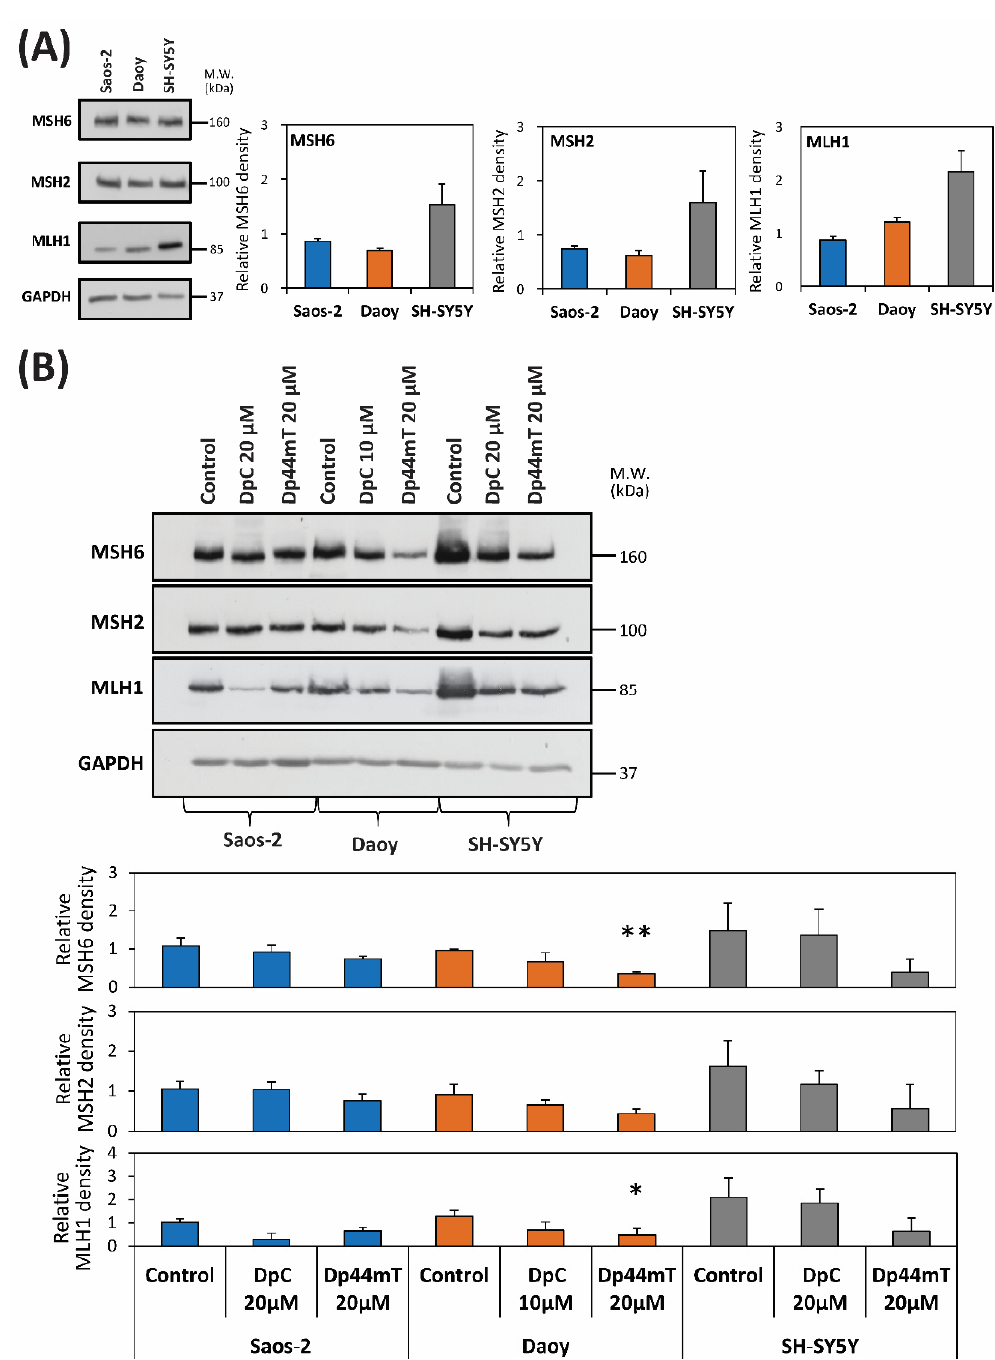
Figure 5. Changes in the expression of MMR proteins after incubation with either control medium, DpC (20 μ M; 10 μ M for Daoy), or Dp44mT (20 μ M) for 24 h/37 °C. ( A ) Western blot analysis of endogenous MSH6, MSH2 and MLH1 levels in untreated cells. ( B ) MSH6, MSH2 and MLH1 levels in Saos ‐ 2, Daoy and SH ‐ SY5Y cells after incubation with DpC or Dp44mT for 24 h. GAPDH served as a protein ‐ loading control. The western blots presented are from a typical experiment of three performed, while the quantitation of the blots is presented as mean ± SD (3 experiments). These data were analyzed using the unpaired Welch’s t ‐ test followed by the Games ‐ Howell post hoc test. * ( p < 0.05) and ** ( p < 0.001) indicate significant differences compared to the respective control group.